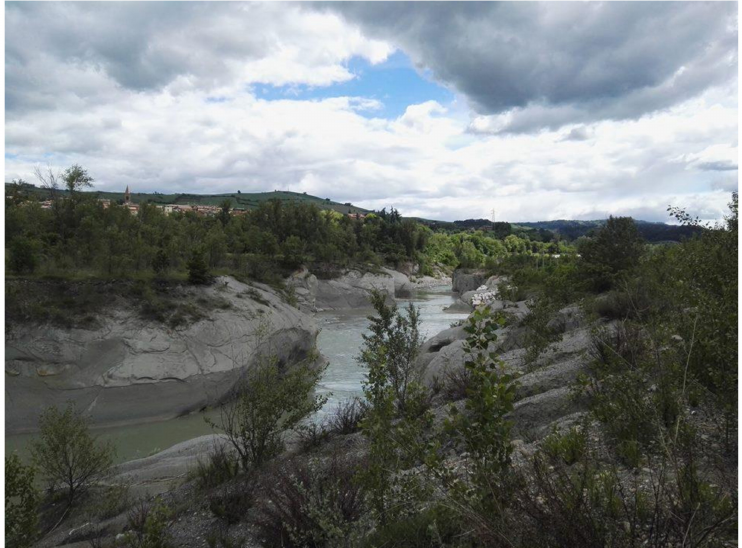
Figure 6. After decades of mismanagement, today the Secchia river (Emilia Romagna, Italy), origi- nally braided, is heavily incised (up to 12 m and even more) and in threat of breaking through the Pleistocene clay substrate with unknown consequences. The process seems unstoppable; indeed, over the years several giant weirs have been installed and then destroyed by powerful floods ([47,48]; photo: Marco